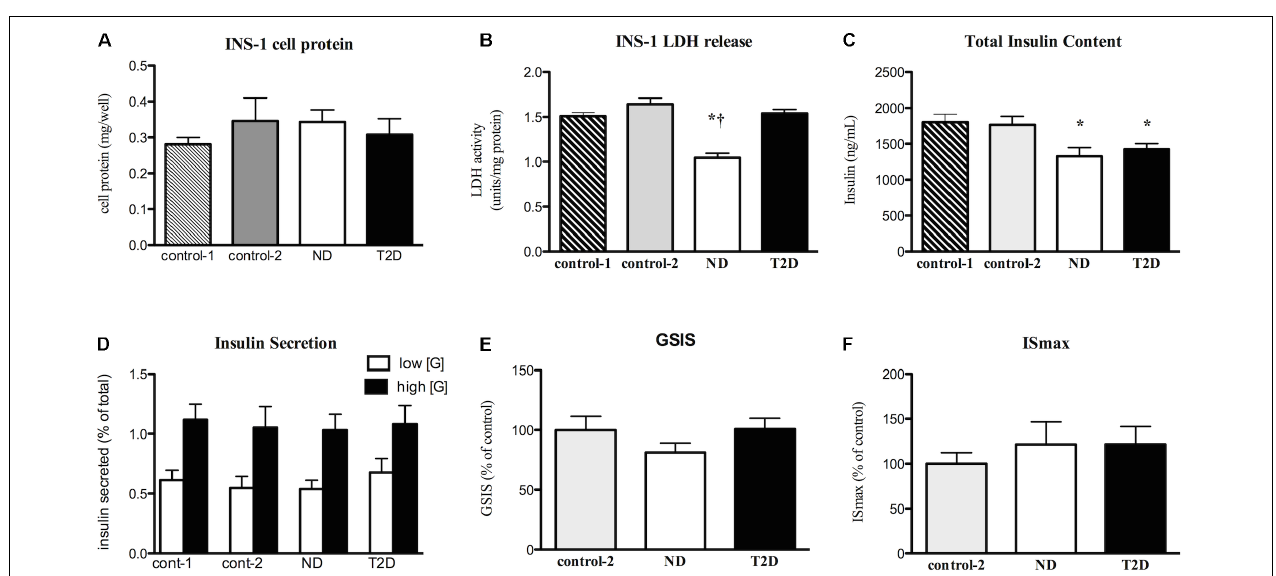
FIGURE 2 | Myokine Secretion. Secretion of selected MK from ND- and T2D-MT. CM collected from untreated MT after 24 h in culture. Results presented as absolute value (A) or normalized to cell protein (B) , Ave + SEM. The numbers of sets of MT from individual subjects evaluated is presented within each bar, measured in duplicate.